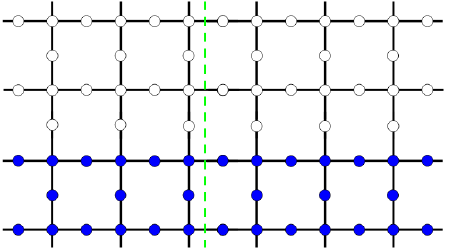
FIG. 4. Lieb lattice with lower half plane filled with particles (in blue). Trace is taken of the half plane to the right of the green dashed line. The flow across the barrier is then given by the difference between the right half trace before and after evolution.